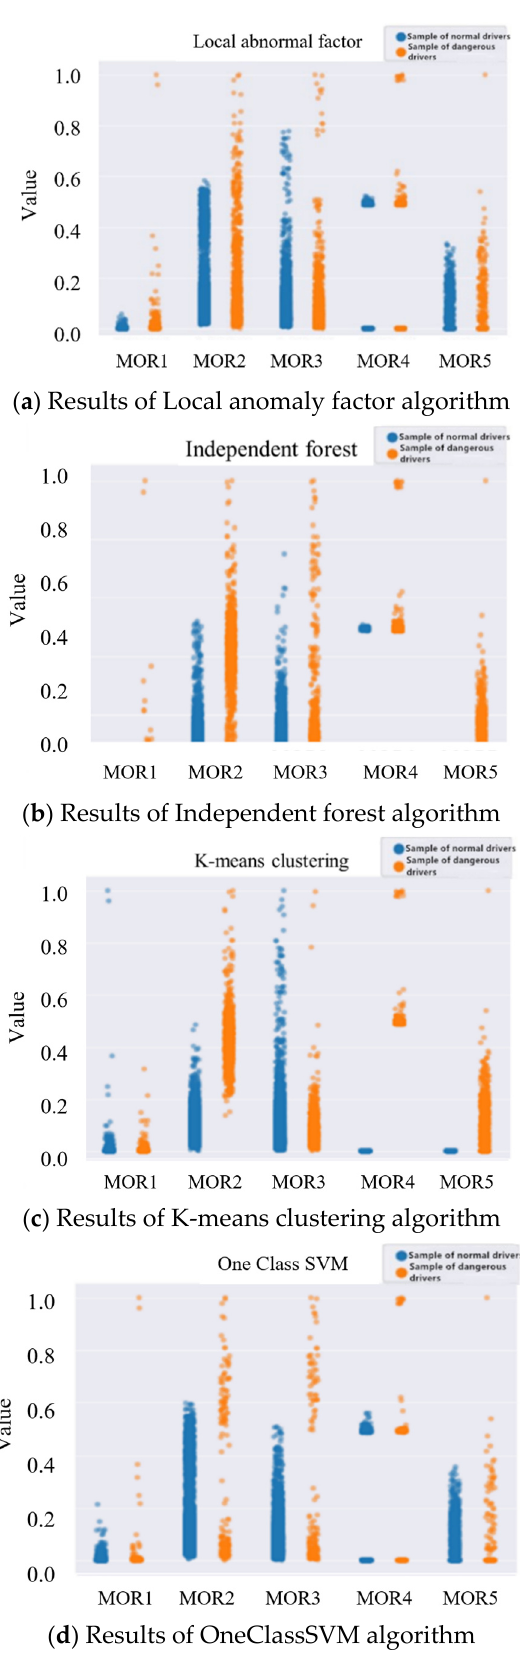
Figure 6. The distribution of MOR.